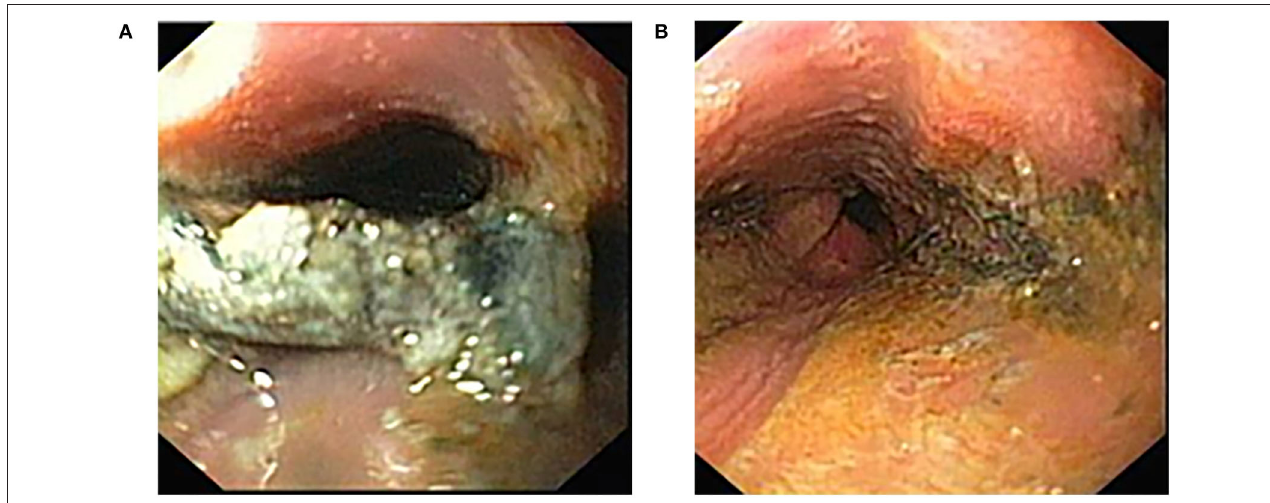
FIGURE 2 | (A) Endoscopic image of a battery in distal esophagus of a 6-year-old child with extravasation of its content and covered with necrotic tissue. (B) Endoscopy showing circumferential wall necrosis of the distal esophagus immediately following battery